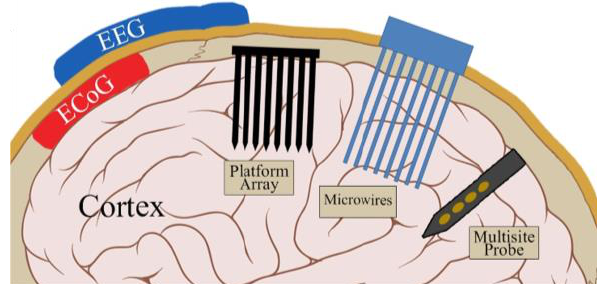
Figure 1. Illustration of the major types of electrode interfaces to the brain: electroencephalography (EEG) are typically discrete electrodes applied to the top of the skull, electrocorticography (ECoG) are electrode arrays supported on a flexible substrate and laid on the surface of the brain, platform array are shanks that penetrate the brain but whose base lies on the surface of the brain, microwires, and multisite probe (where multiple electrodes reside on a single shank). Reproduced with permission [1].